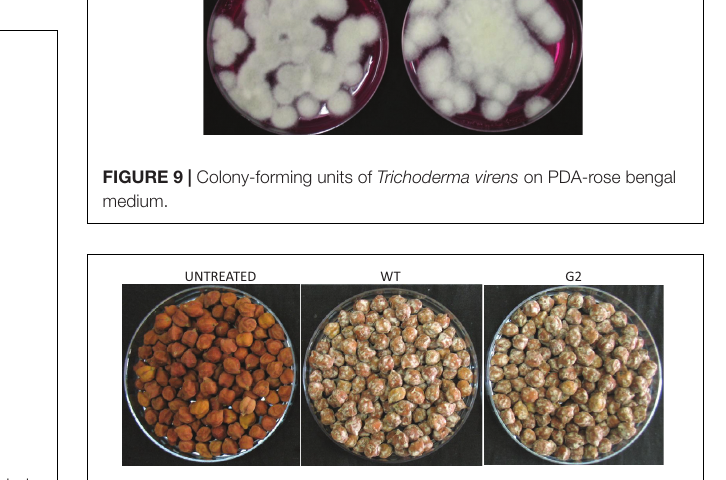
FIGURE 10 | Seeds treated with wild type and G2